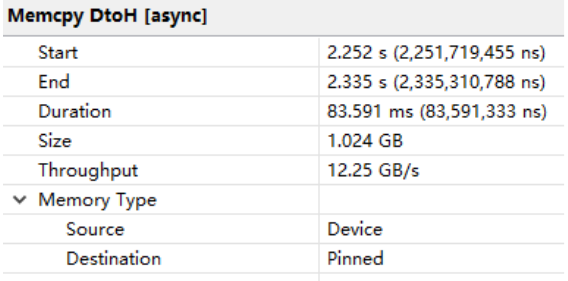
Fig. 11. The Memcpy DtoH properties on calculating the distance